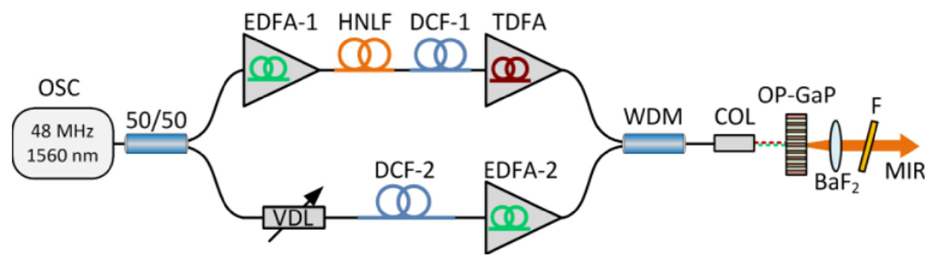
Figure 7. MIR source ranging from 6 to 9 µm based on an all-fiber system. Reprinted with permission from [115] © The Optical Society. The pulses from the Er-doped fiber oscillator (OSC) are equally split into two branches. One part is amplified in an Er: fiber amplifier (EDFA-1) to approximately 120 mW and enters a polarization-maintaining (PM) highly nonlinear fiber (HNLF). The spectrum of the input pulse is then shifted towards longer wavelengths via Raman-induced soliton self-frequency shift (SSFS) in the HNLF. Finally, the output pulses from the HNLF are amplified to 150–235 mW in a Tm: fiber amplifier (TDFA), serving as the signal pulses for the DFG process. The second part is amplified to 175 mW in EDFA-2. Both arms are combined together into a common single-mode fiber with a 1550/2000 nm wavelength division multiplexer (WDM). The temporal overlap between the pump and signal pulses is adjusted by a fiber-coupled variable delay line (VDL). The pump and signal beams are focused on the nonlinear crystal together for MIR generation. The generated MIR (idler) beam is collimated with a 75 mm barium fluoride (BaF 2 ) lens. The residual pump and signal lights are blocked by a long-pass filter (F) with a 4.5 µm cut-on wavelength, meaning that only MIR pulses can travel through it.